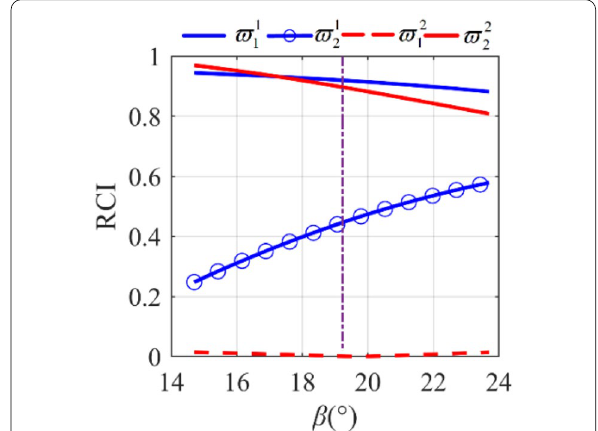
Figure 13 RCI near the constraint singularity